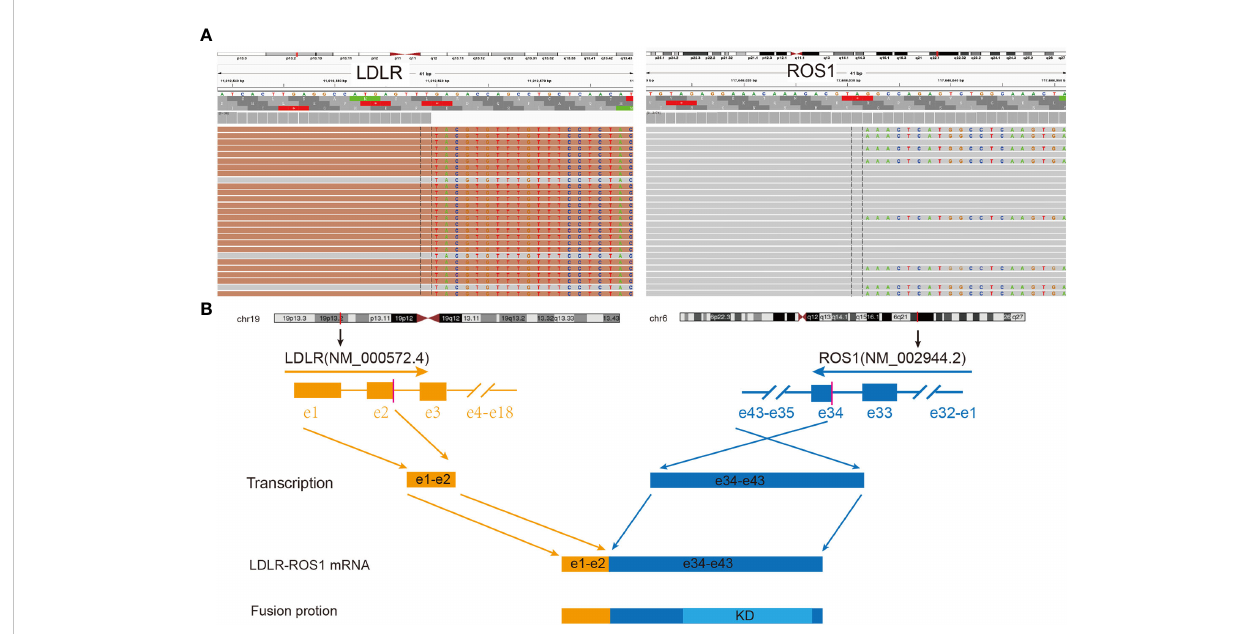
FIGURE 2 Identi fi cation and veri fi cation of LDLR-ROS1 fusion in this case. (A) RNA sequencing reads indicating visualization of the LDLR and ROS1 fusion regions using the Integrative Genomics Viewer (IGV) software. The fusion breakpoints are localized at chr19: p13.2: 11,212,559 and chr6: q22.1: 117,646,031, respectively; (B) Schematic of genomic rearrangement involving the fusion breakpoints at mRNA and protein levels; the transcript resulted in exons 1 – 2 of LDLR fused to exons 34 – 43 of ROS1 , including kinase domain. LDLR , low-density lipoprotein receptor; ROS1 , ROS proto- oncogene 1; Orange color represents LDLR ; Blue color represents ROS1 ; KD, kinase domain; e,